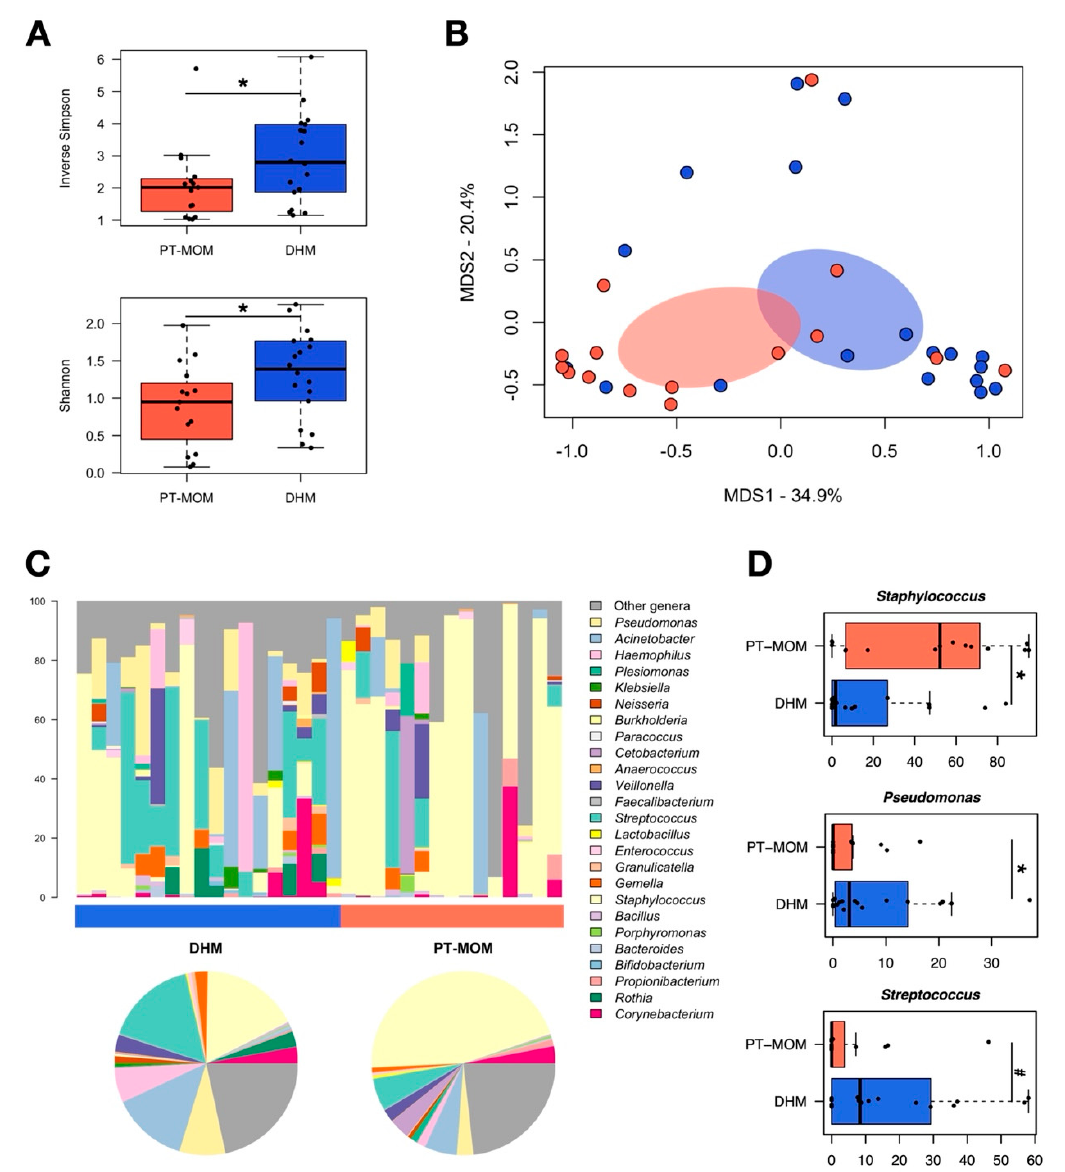
Figure 1. Milk microbiota from preterm-delivering mothers compared with donor human milk microbiota. ( A ) Boxplots showing the distribution of alpha diversity, assessed by the inverse Simpson ( top ) and Shannon ( bottom ) indices, in the milk microbiota from preterm-delivering mothers (PT-MOM) and donor human milk microbiota (DHM). *, p value ≤ 0.05, Wilcoxon test. ( B ) Principal coordinate analysis (PCoA) of the Bray-Curtis distances between the genus-level microbial profiles of the two study groups, PT-MOM (salmon) and DHM (blue). A significant separation was found ( p = 0.02, permutation test with pseudo- F ratio). ( C ) Genus-level relative abundance profiles of PT-MOM and DHM samples. Data are shown in the bar charts for each sample and in the pie charts as mean values in the study groups. ( D ) Boxplots showing the relative abundance distribution of bacterial genera significantly differentially represented between groups. *, p ≤ 0.05, Wilcoxon test. For Streptococcus, only a trend was found (#, p = 0.08).